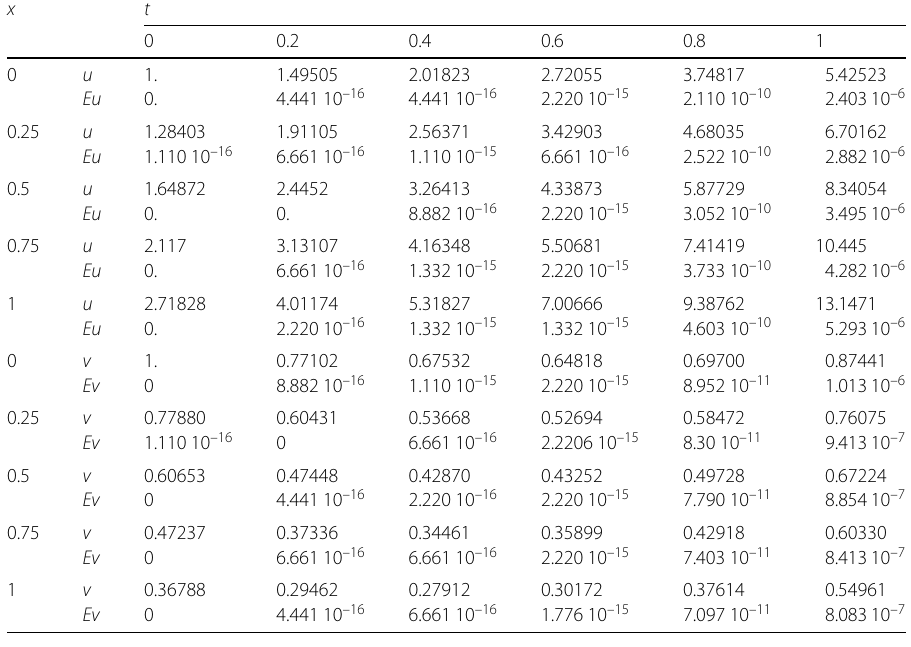
Table 1 Solution and residual error for Example 3 when α = 0.7 and β = 0.8 at several values of x and t using 60 terms of the series ( (cid:2) =